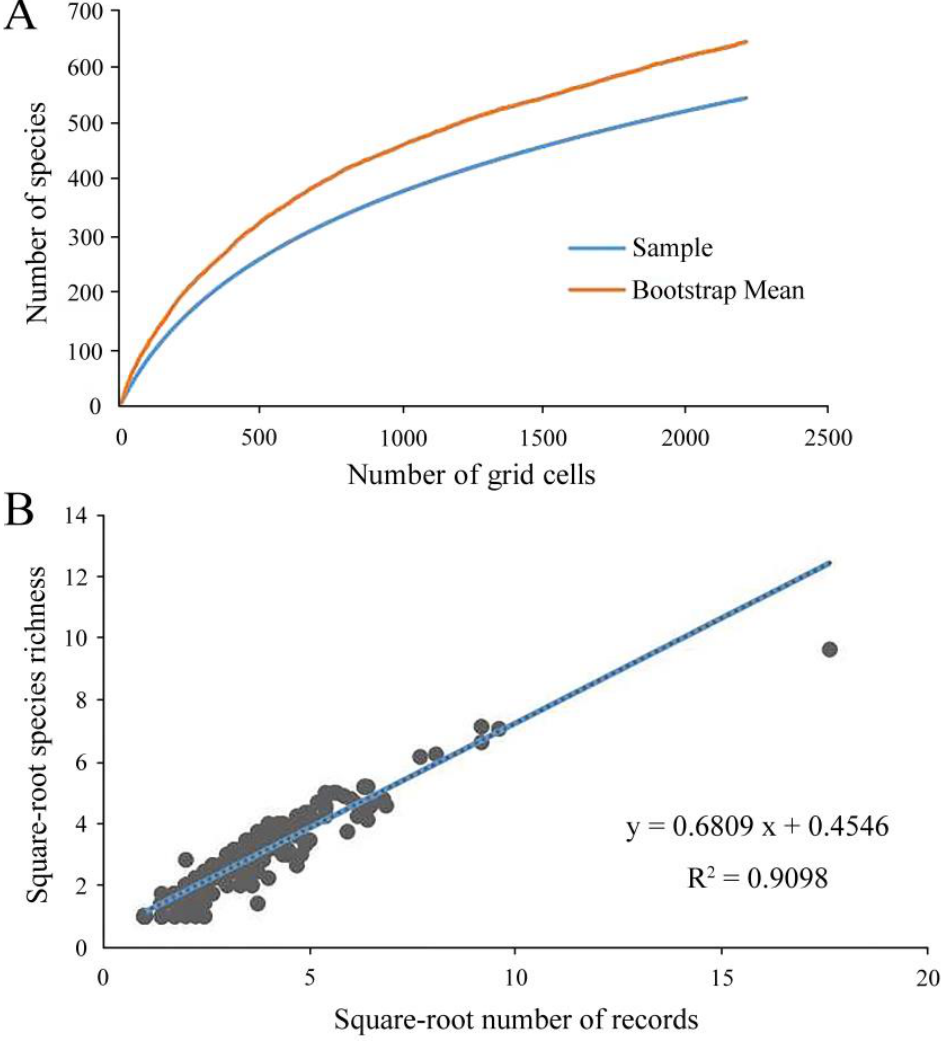
Figure 2. ( A ) Species accumulation curves for Tenebrionidae in arid and semiarid areas of China; ( B ) Linear regression (y = 0.6809x + 0.4546) for the number of records and species richness in the 1° grid size.